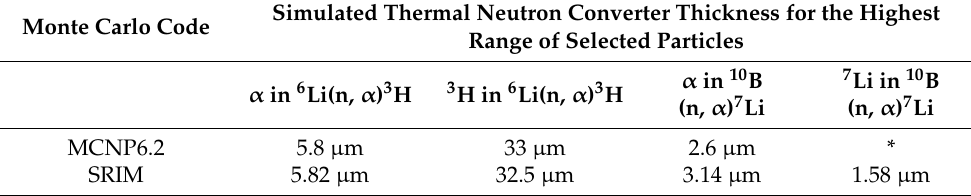
Table 1. Correlation of Monte Carlo simulation